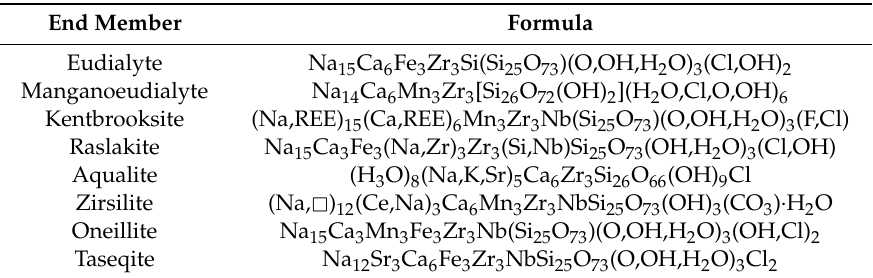
Table 1. Formulae for end members of the eudialyte-group mentioned in the